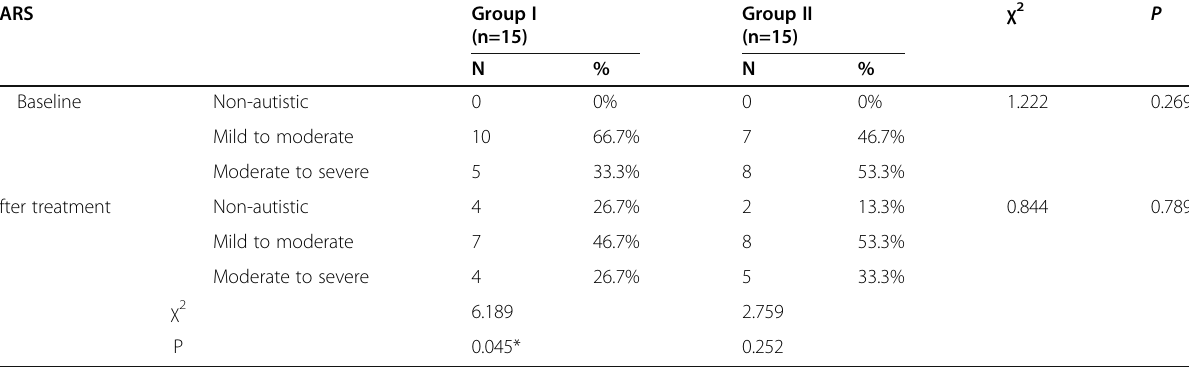
Table 2 Comparison between baseline CARS assessment and after treatment CARS